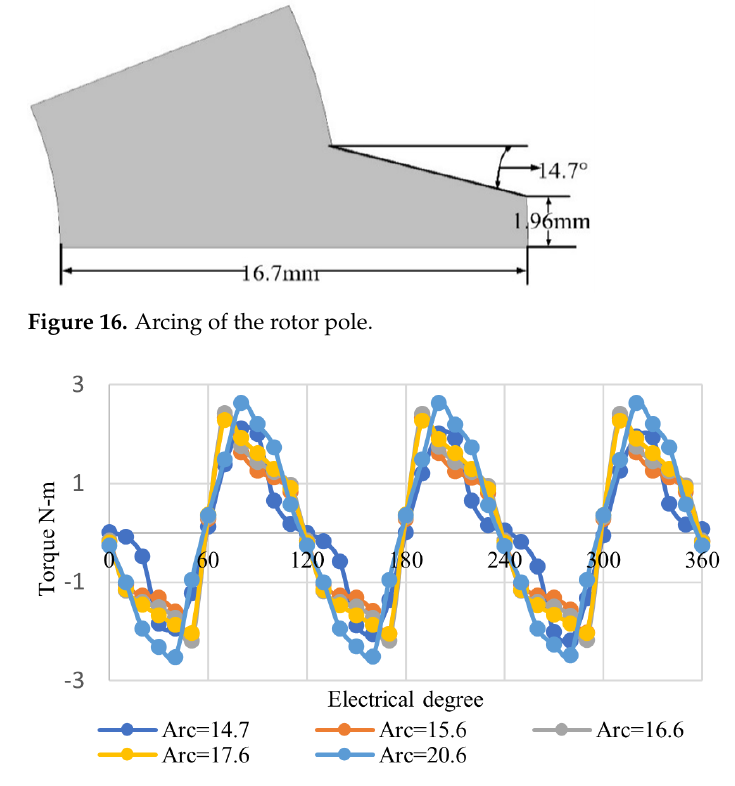
Figure 17. Different arcing result.